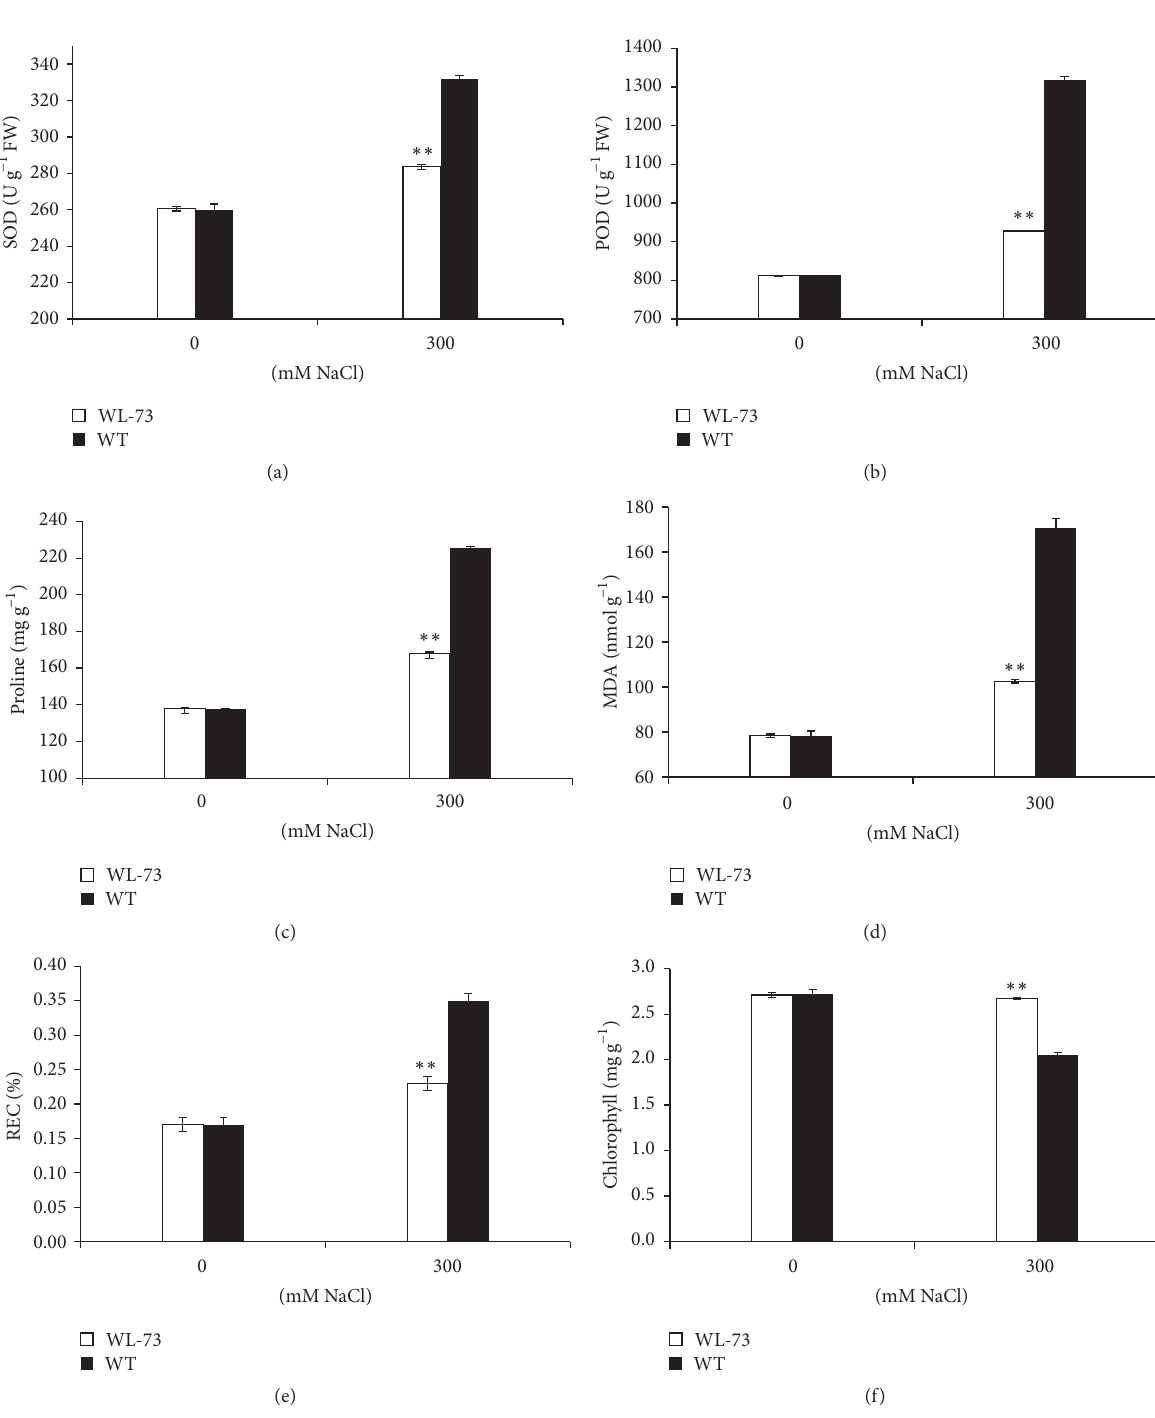
Figure 4: Effects of NaCl stress on the SOD, POD, Pro, MDA, REC, and chlorophyll contents of WT maize and WL-73 transgenic maize plants. WT and WL-73 were treated with 0.5x Hoagland’s nutrient solution and either 0mM NaCl (control) or 300 mM NaCl for 7 days; then, the SOD, POD, Pro, MDA, REC, and chlorophyll contents were measured. (a) SOD content; (b) POD content; (c) Pro content; (d) MDA content; (e) REC; (f) chlorophyll content. WT, wild-type maize LH1037; WL-73, LH1037 plant transformed with BcWRKY1. ∗∗ indicates a significant difference at 0.01 according to the LSD test ( 𝑛 = 3 ). The standard error is based on the average of three biological replicates. Note: the SOD, POD, Pro, MDA, and REC of WL-73 were significantly lower than those of WT ( 𝑃 < 0.01 ), while the chlorophyll content of WL-73 was higher than that of WT under 300 mM NaCl treatment for 7